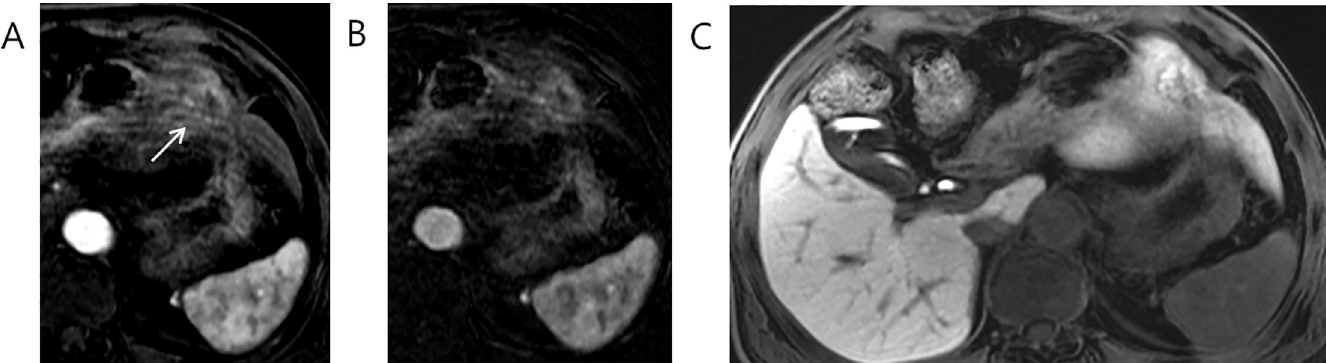
Fig 3. 73 year old male patient with Edmondson grade I HCC. Rim APHE is shown in (A) late arterial phase, (B) arterial subtraction image and (C) hepatobiliary phase. This hepatic observations shows iso-to-high signal intensity in hepatobiliary phase.